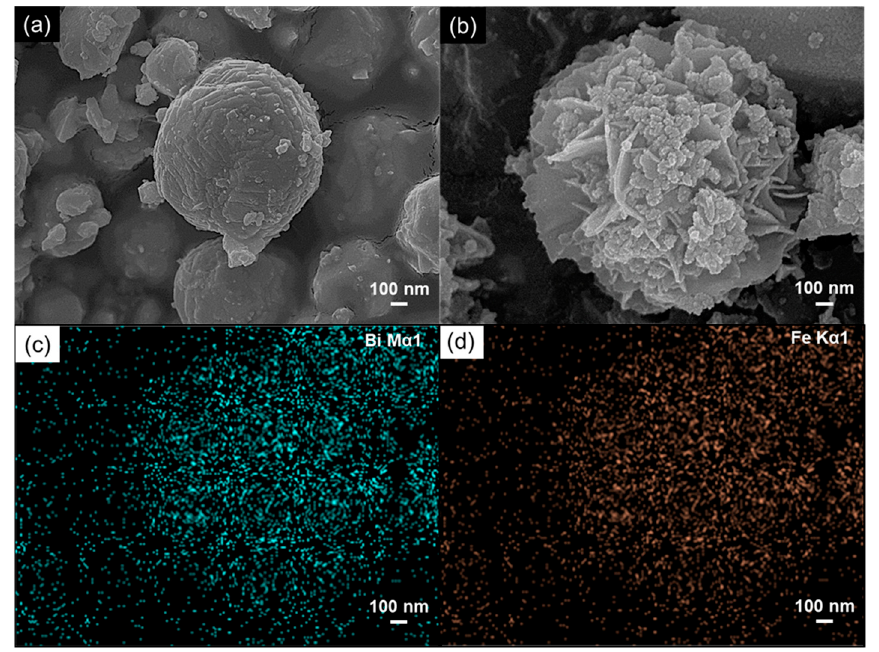
Figure 1. SEM images of BV ( a ) and FNBV–3 ( b ); SEM–EDS elemental mapping of FNBV–3; ( c ) Bi and ( d ) Fe. and ( d )